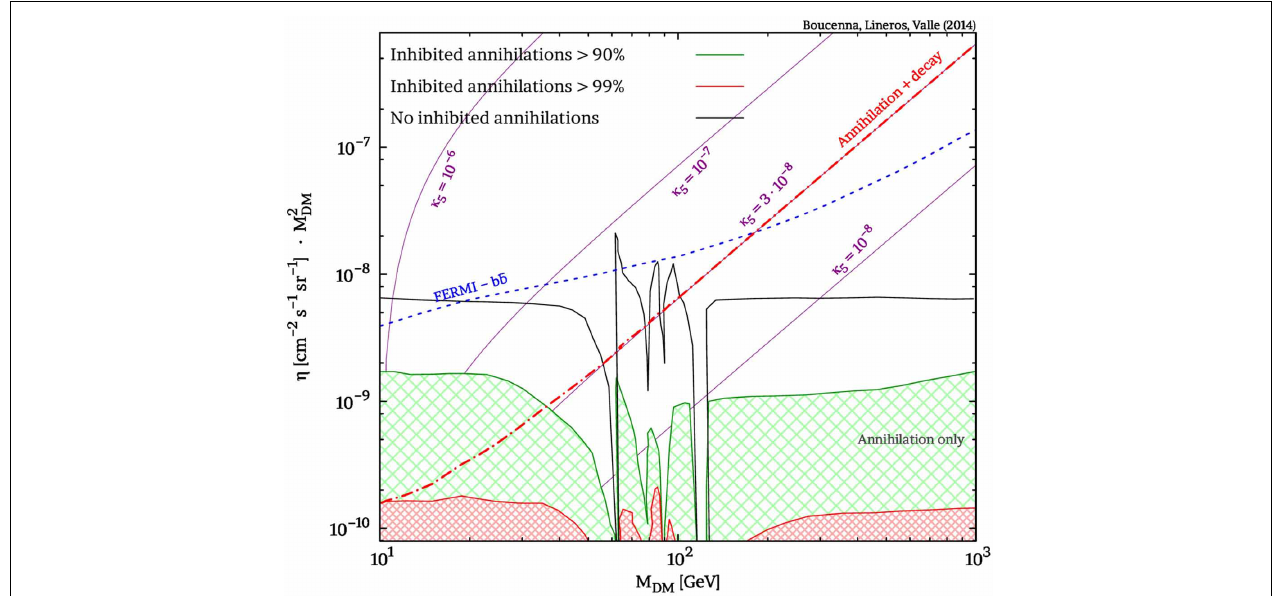
FIGURE 3 | The η –flux associated with dark matter decay vs. DM mass (see text for details). We give estimates for the annihilation flux for the cases of 90%, 99%, and no suppression (solid green, red, and black lines respectively). Purple lines correspond to decay signal induced